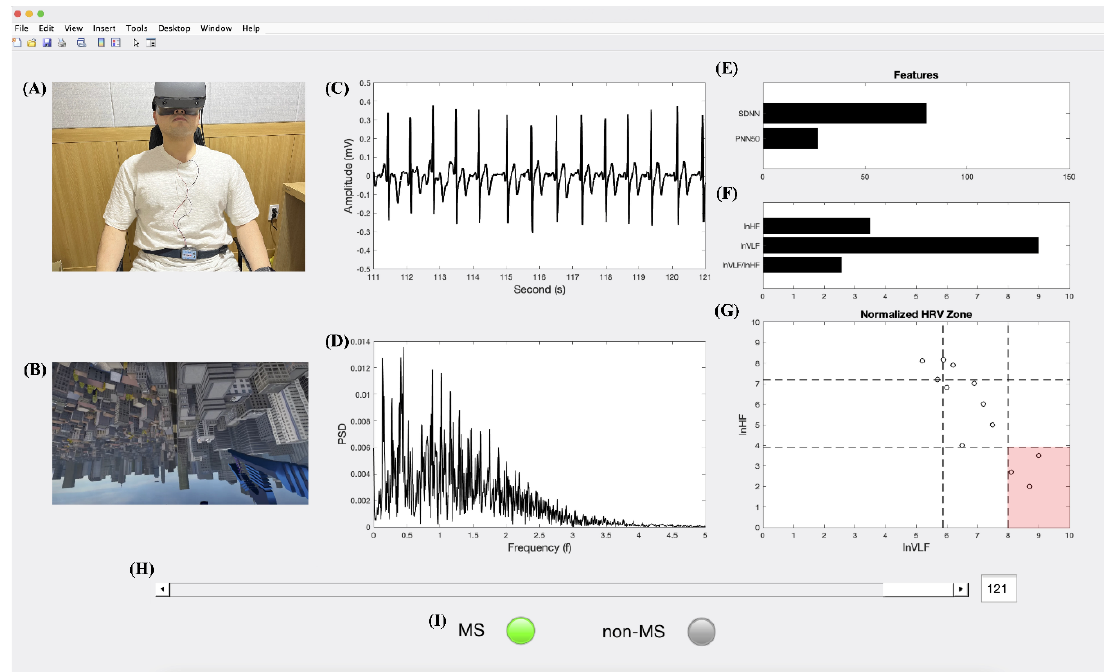
Figure 9. Real-time system for assessing MS using cardiac activity. ( A ) User monitor cam. ( B ) VR scene. ( C ) ECG raw signals and detecting the R-peaks. ( D ) HRV by FFT. ( E ) Results of the cardiac time domain indices (i.e., SDNN and pNN50). ( F ) Results of the cardiac frequency domain indices (i.e., ln HF, ln VLF, and ln VLF/ ln HF ratio). ( G ) Results of the nine zone in autonomic balance by the normalized HRV. ( H ) Sliding bar in each time log. ( I ) The binary decision for MS.